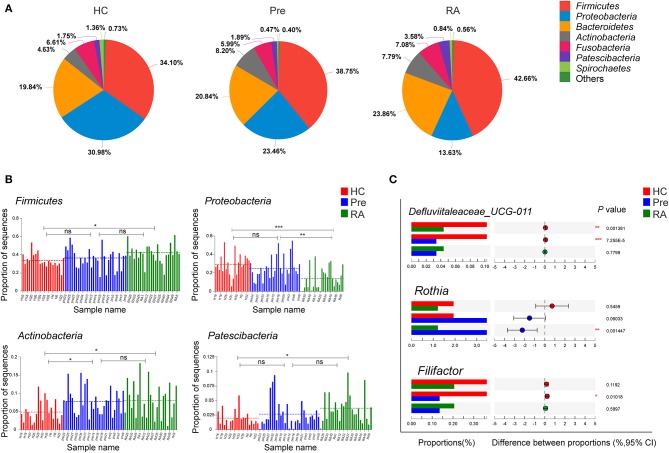
Differentially abundant taxa at phylum and genus level. (A,B) The relative abundance of dominant phyla dynamically altered at different stages of RA as represented by healthy controls (HCs), high-risk for RA individuals (Pre), and RA patients (RA). (C) Characteristic genera changes were found in high-risk individuals. *p < 0.05; **p < 0.01; and ***p < 0.001; ns, non-significant.